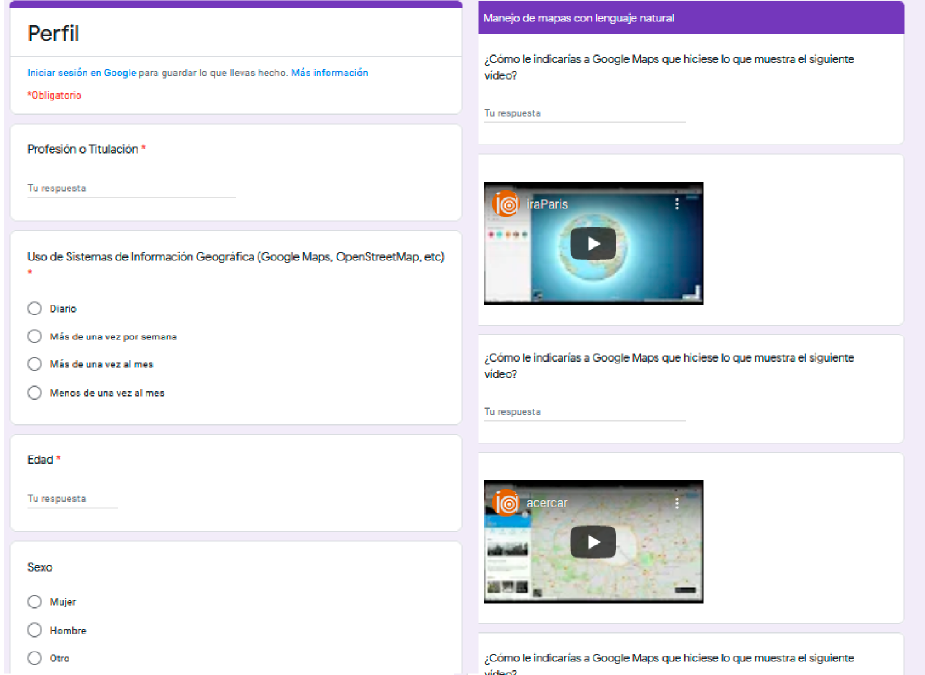
Figure 3. Questionnaire using videos.